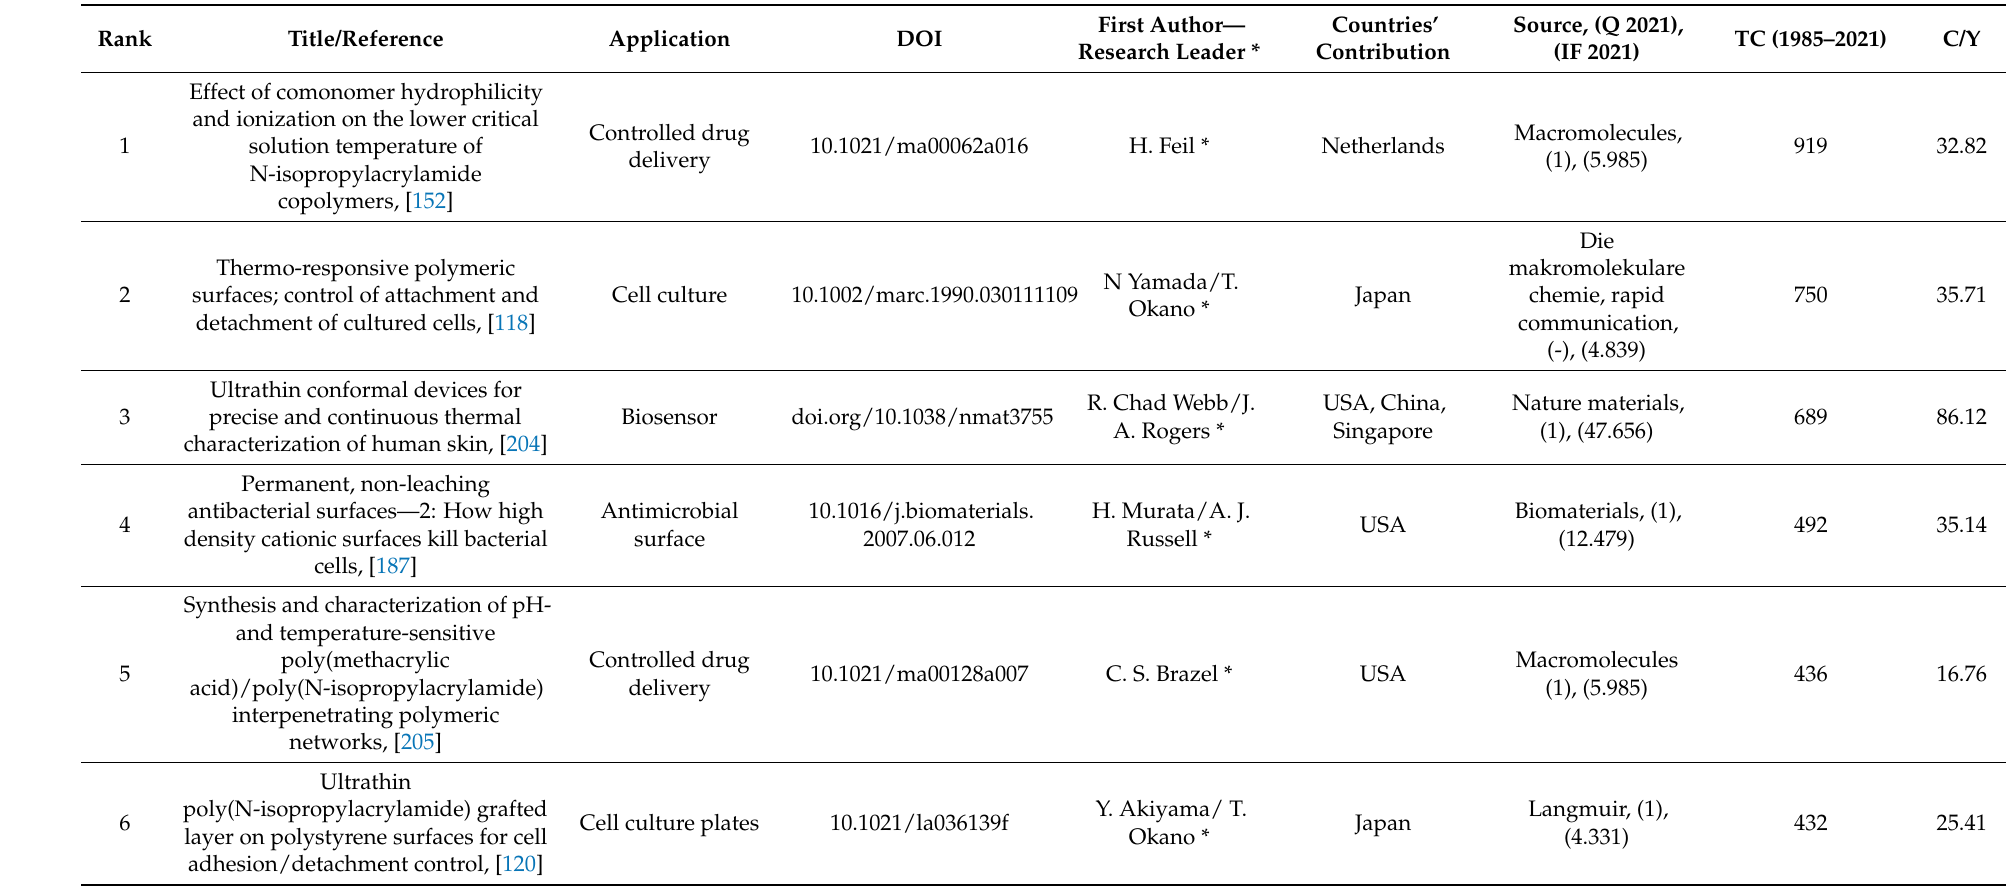
Table 4. Top 10 highly cited original research articles on FPBMs prepared by